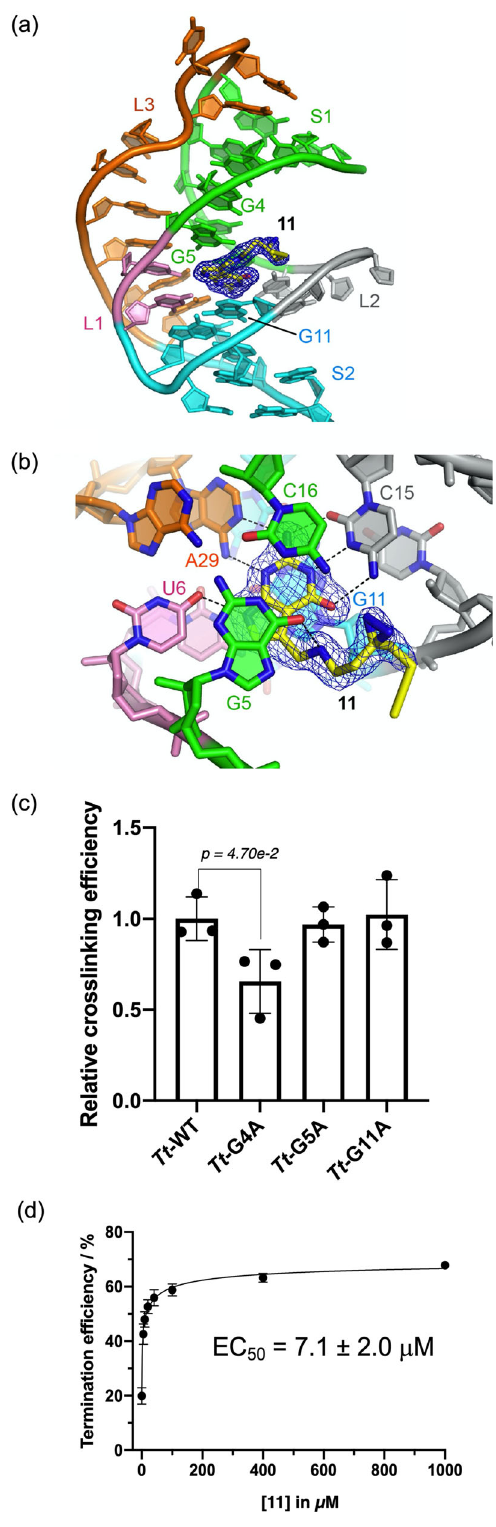
(Fig. 7d). Together, the results of these sequencing and qPCR experiments indicate that these RNAs selectively bind to this ligand. Further investigation is underway to map these cross- links and fully characterize these interactions. Extension of this c-Chem-CLIP crosslinking pull-down strategy to live cells in an effort to con fi rm the relevance of these potential interactions with 11 is currently underway.